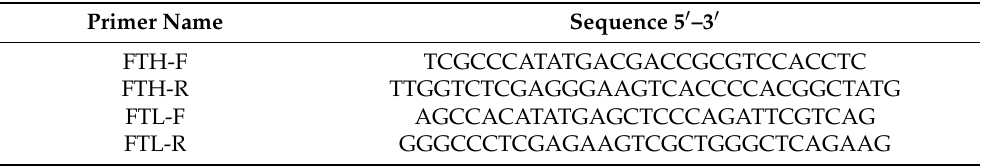
Table 1. Sequences of primers used in this work with the introduced restriction endonuclease